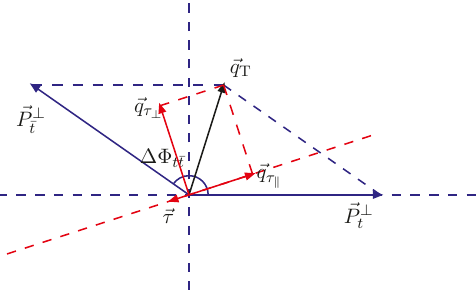
stands t (¯ t ) is the azimuthal opening angle between t ¯ t